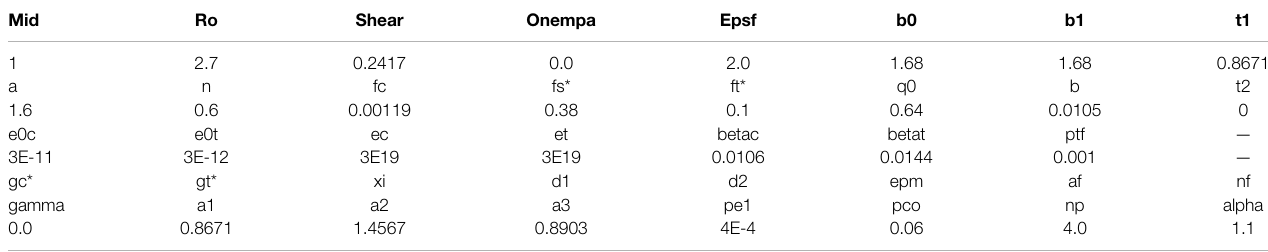
TABLE 2 | RHT constitutive model parameters. Mid